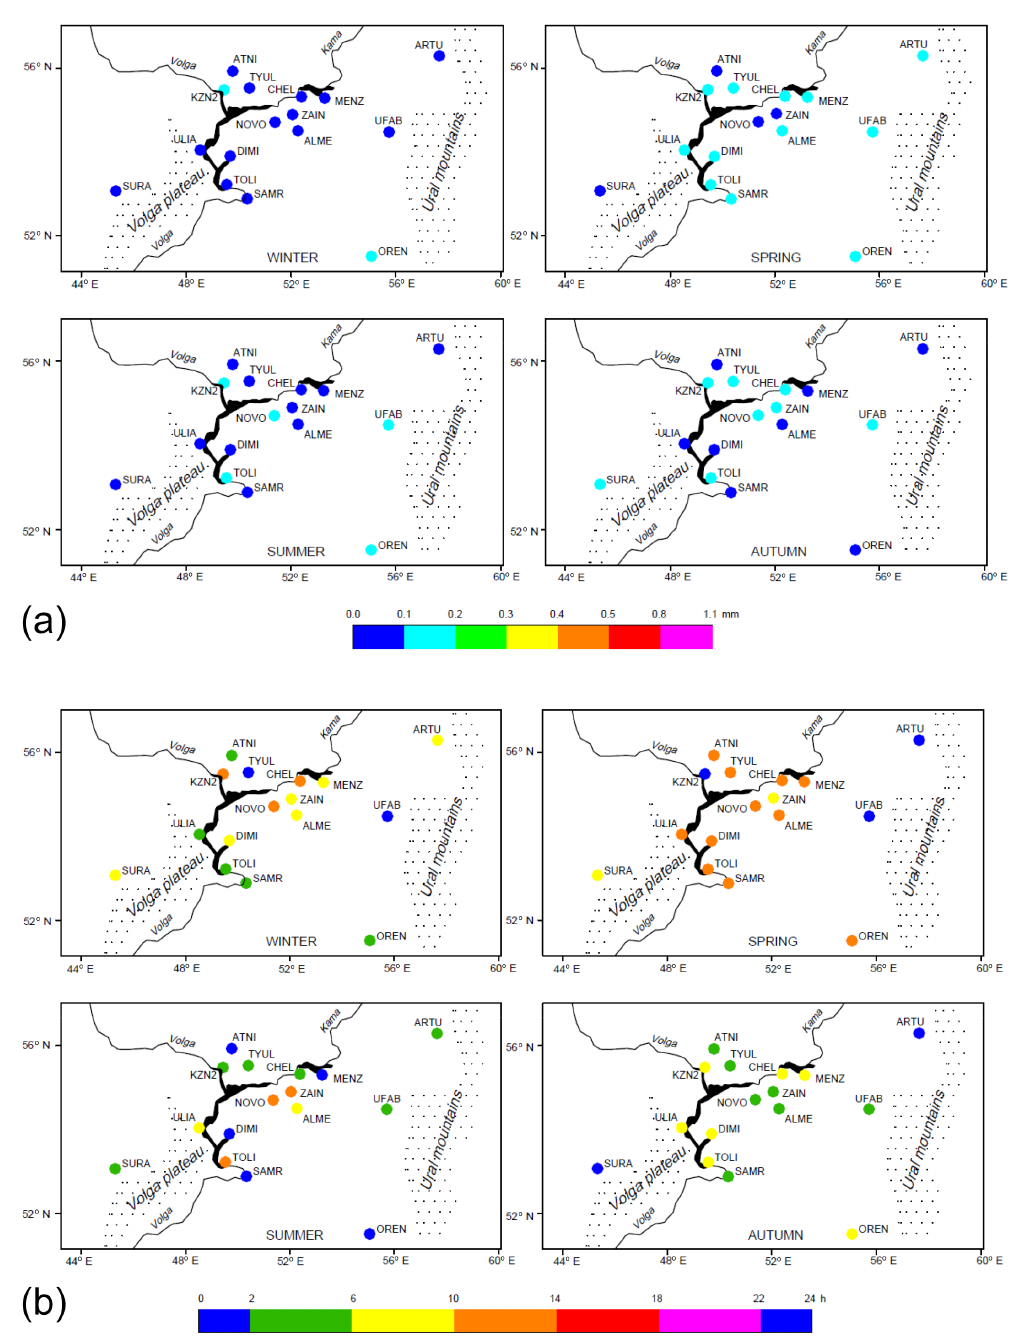
Figure 3. Amplitude (a) and time at the first maximum (b) of the semidiurnal